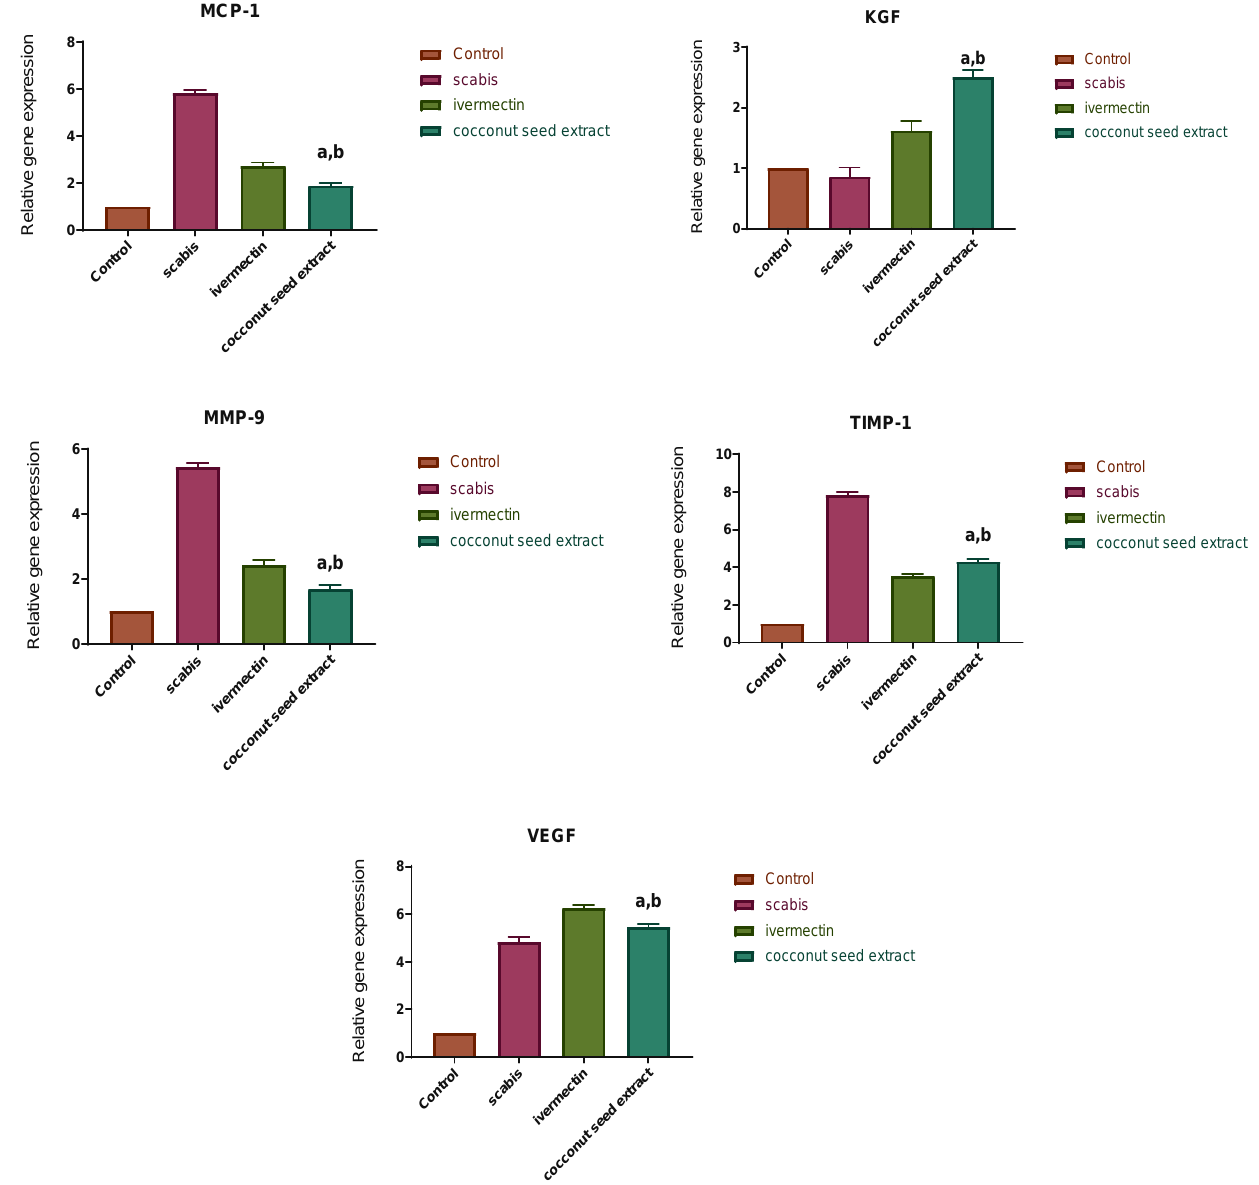
Figure 7. Relative gene expression in skin tissue of different animal groups using qRT-PCR. After normalization to GAPDH, the data reflect a fold in expression compared with the normal control group. The bars represent mean ± SD. To determine if there is a significant difference between groups, a one-way ANOVA test was performed with (a) p < 0.05 compared with the normal control group and (b) p < 0.05 compared with the market-drug-induced group.